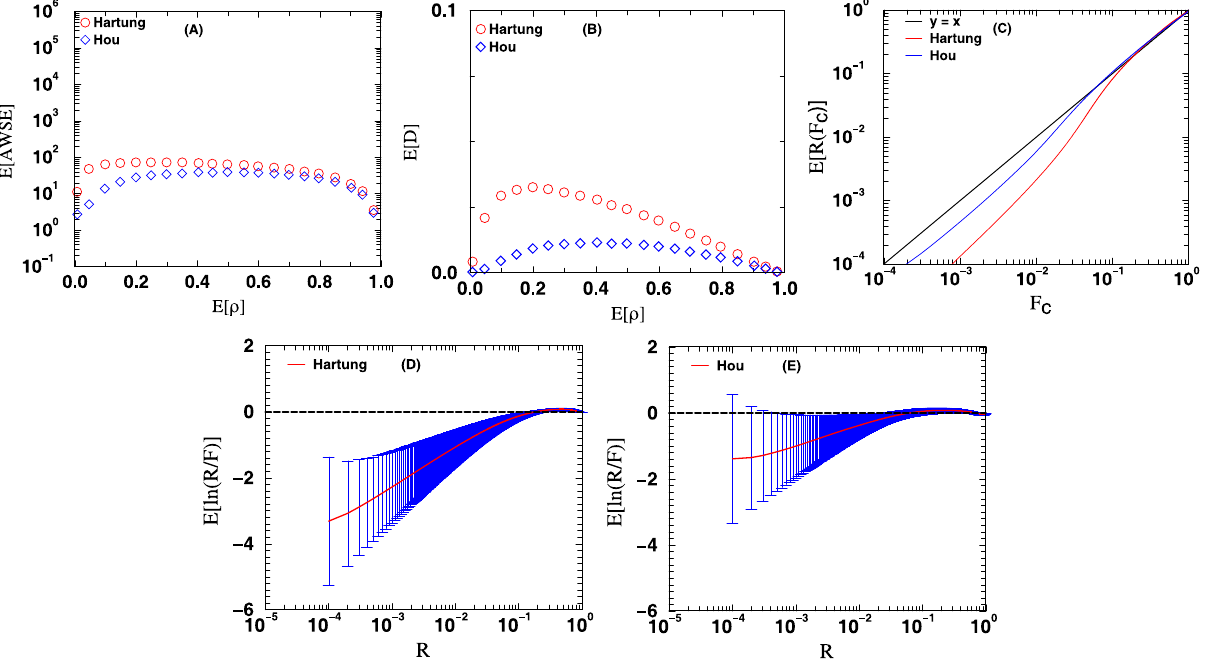
Figure 6. Methods that combine weighted correlated P -values: Hartung and Hou. The curves plotted above are the curves for the four different measures used to evaluate the accuracy of the computed P -value from combining the P -values of 12 P -value vectors. See text for more details.